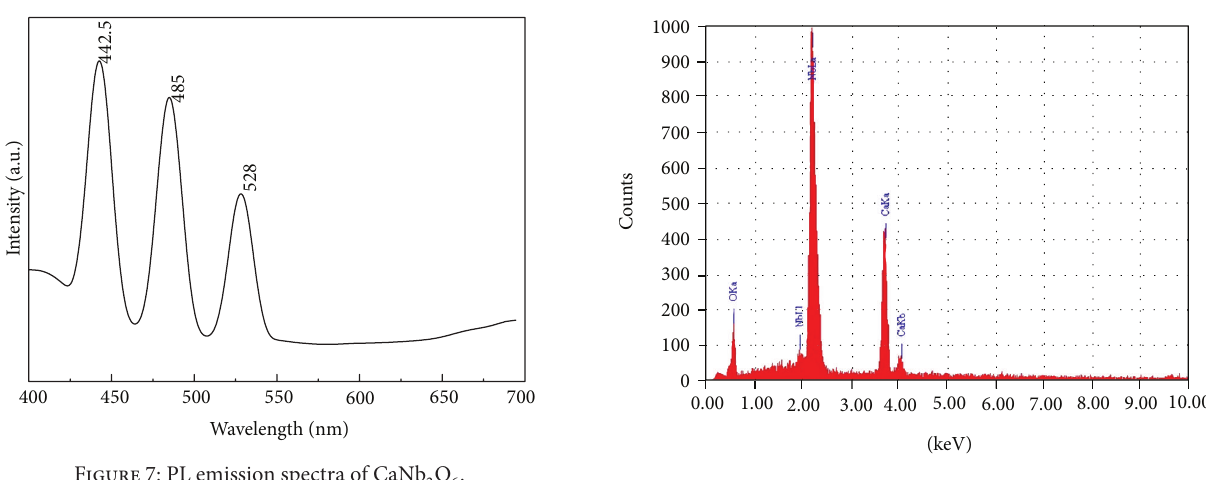
Figure 9: EDAX pattern of CaNb 2 O 6 .